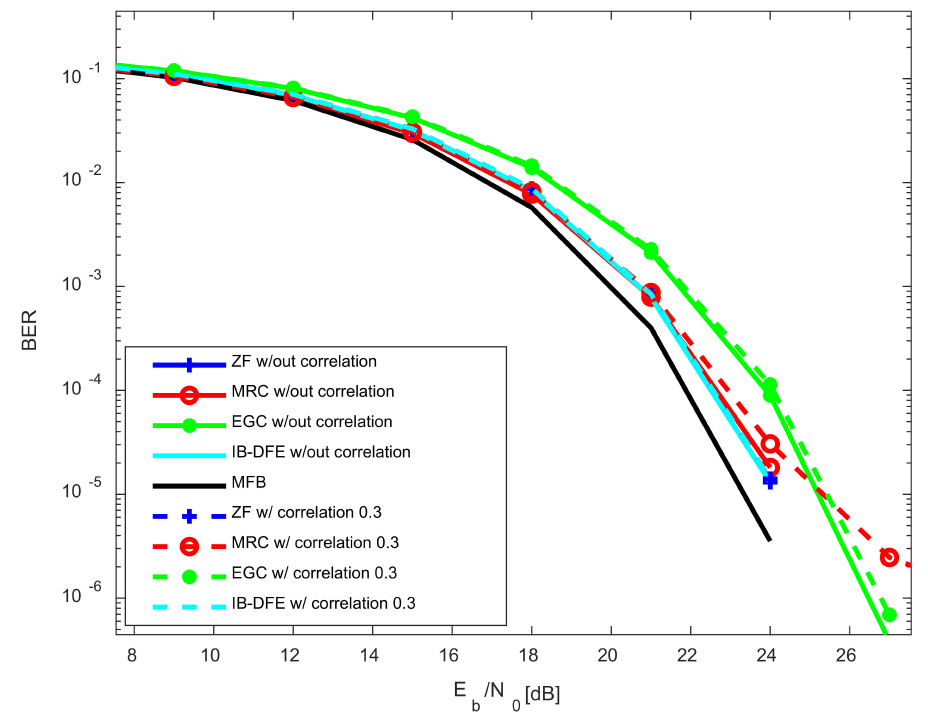
Figure 5. Results for 4 × 32 MIMO, with channel estimation, with impulsive noise, with LDPC codes, and without channel correlation versus with correlation 0.3 between antenna